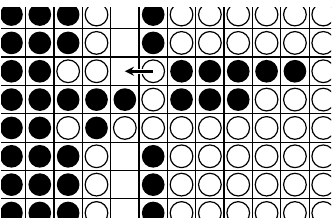
Figure 43. The center right WHITE